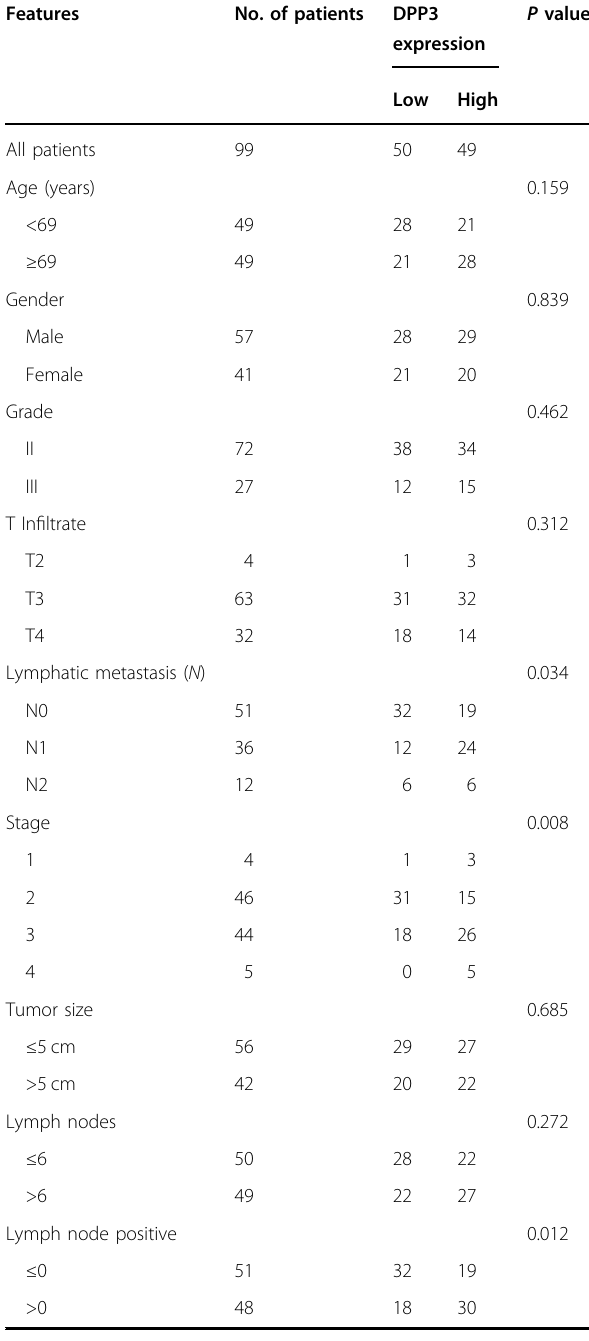
Table 1 Expression patterns in colorectal cancer tissues and para-carcinoma tissues revealed in immunohistochemistry analysis.